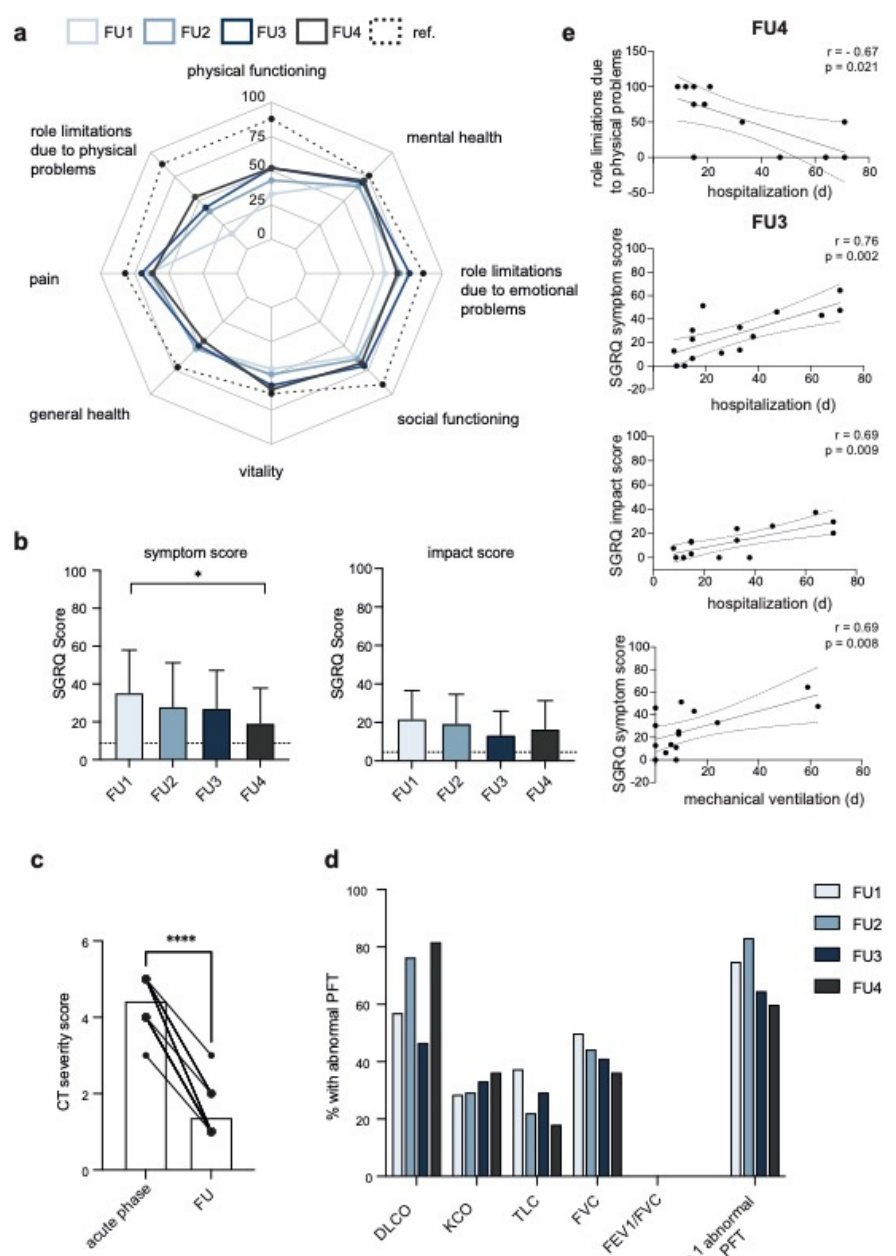
Figure 1. Follow-up assessments of HrQoL, pulmonary function and radiological CT severity scores in critical COVID-19 survivors. ( a ) The radar plot shows the SF-36 scores of eight dimensions for all FUs and reference values (healthy men aged 45–54) in dashed lines. A score of 100 represents the best subjective health state. ( b ) Boxplots show the mean ( ± SD) SGRQ symptom (left panel) and impact score (right panel) of all follow-up assessments (FU). The dashed lines indicate mean reference scores for the age group 50–59. ( c ) The CT severity scores from chest CTs performed at the time of admission (acute phase) and during follow-up (119 ± 15.3 days upon discharge) are plotted, and the lines connect the scores of each individual patient. ( d ) The percentage of patients with abnormal PFTs ( ≤ 80% of the predicted value) is presented. ( e ) The scatter plots show the Spearman correlations with a 95% confidence interval for the FU3 or FU4. The Spearman r and p -values are annotated. See Figure S3 for all FUs. Significance was tested by the one-way-ANOVA with Dunnett’s multiple comparison test ( b ) and by the Wilcoxon matched-pairs signed rank test ( c ), and is indicated by asterisk (* = p < 0.05; **** = p < 0.0001). Non-significant levels are not labelled. CT, computed tomography; d, days; DLCO, lung diffusion capacity for CO; FEV1, forced expiratory volume at the first second of maximal expiration; FVC, forced vital capacity; FU, follow-up appointment; KCO, carbon monoxide transfer rate; PFT, pulmonary function test; ref., reference; SGRQ, St. George’s Respiratory Questionnaire; TLC, total lung